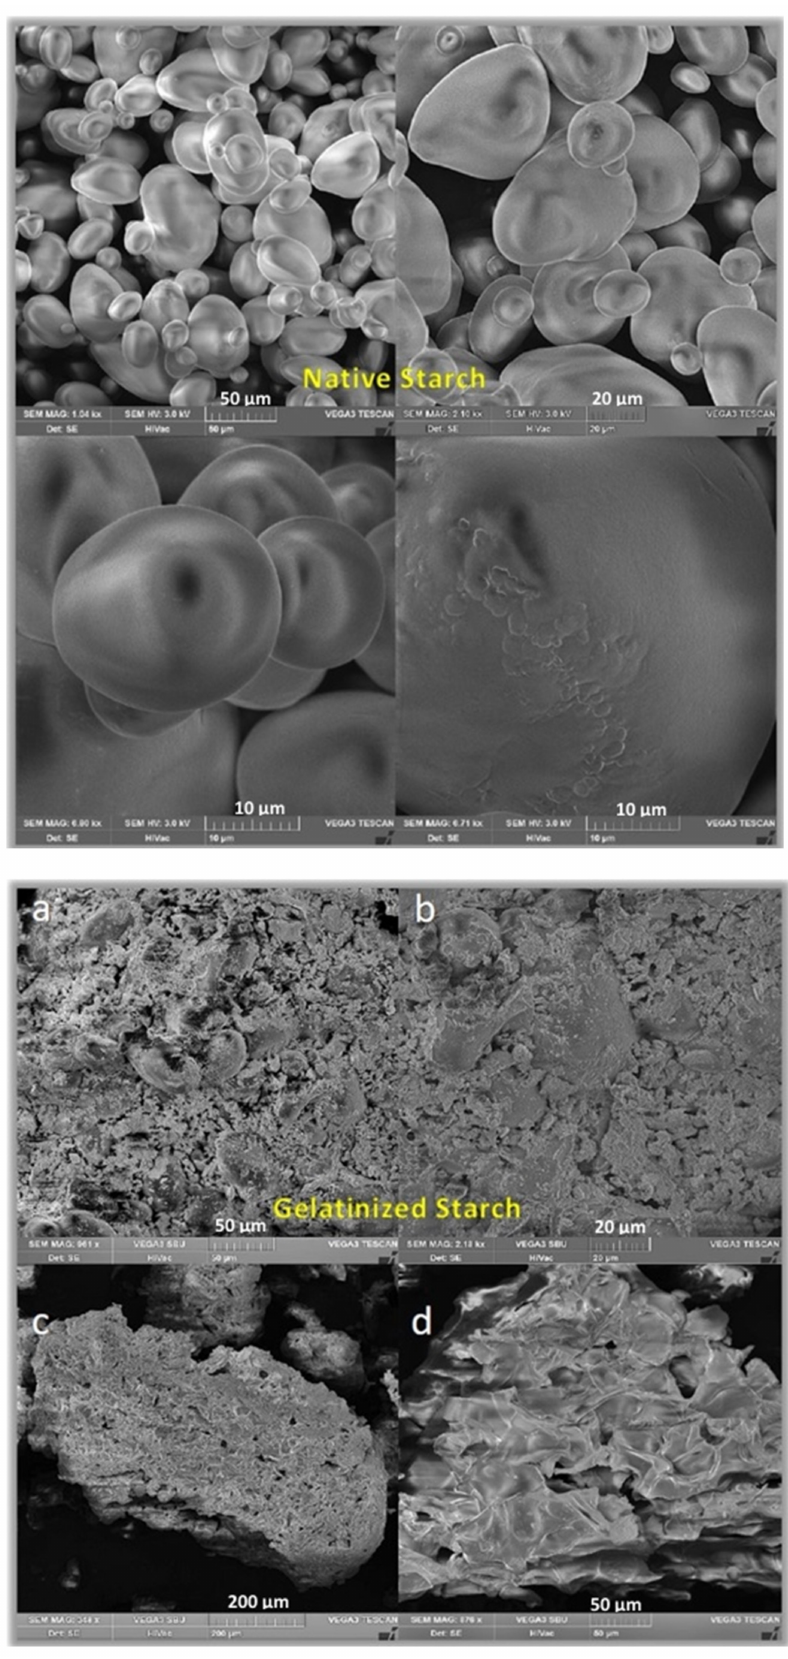
Figure 3. Starch before aand after gelatinization ( a , b )—partial; ( c , d )—full; images made by authors of manuscript, Jan Dlugosz University, Czestochowa,